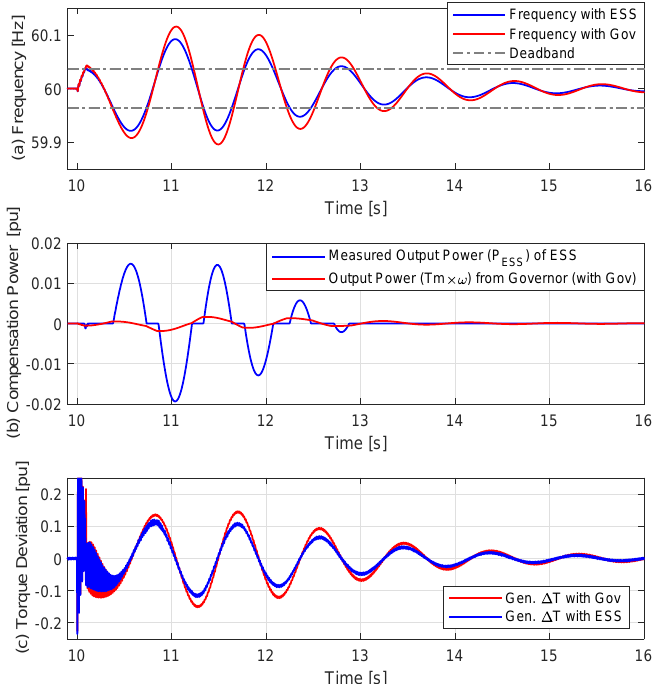
Figure 14. Temporary fault case; ( a ) generator frequency, ( b ) output power of ESS and Governor, ( c ) electrical torque of